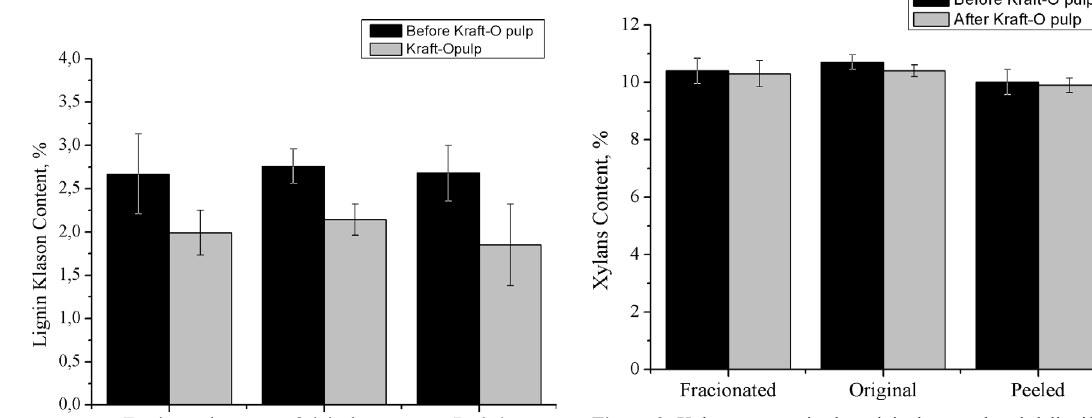
Figure 2. Xylans content in the original, treated and delignified with oxygen